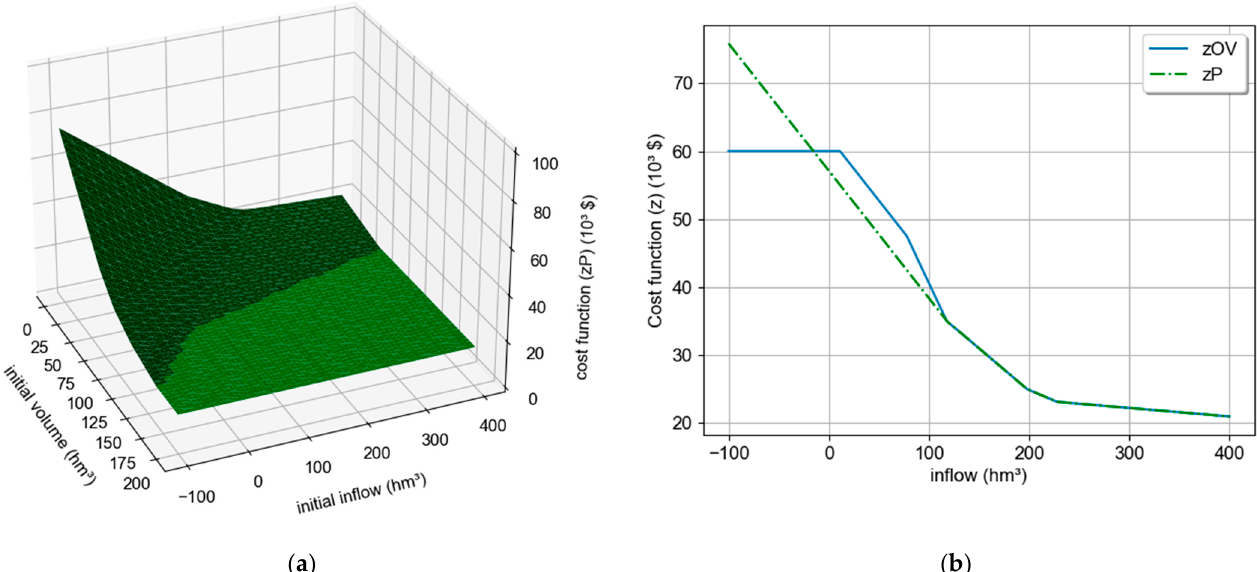
Figure 5. ( a ) Cost function (zP) (10 3 $) per inflow (hm 3 ) by the penalty approach. ( b ) penalty approach (dashdot green), and optimal value approach (blue).